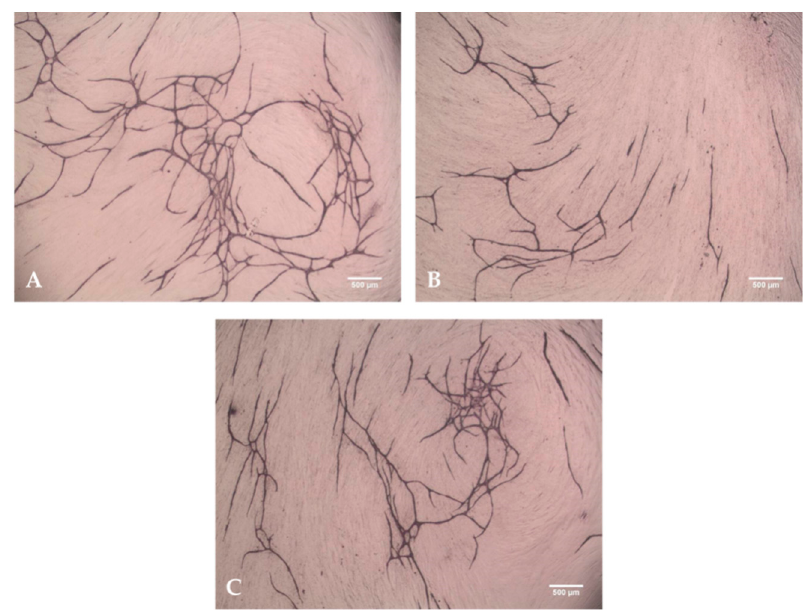
Figure 3. Tubuli and Nets visible after Angiogenesis Assay. After staining with BCIP/NBT-Substrate, tubuli and net-structures became visible. ( A ) Titanium implant functionalized with VEGF; ( B ) titanium implant functionalized with HMGB1; and ( C ) titanium implant functionalized with a combination of VEGF + HMGB1.